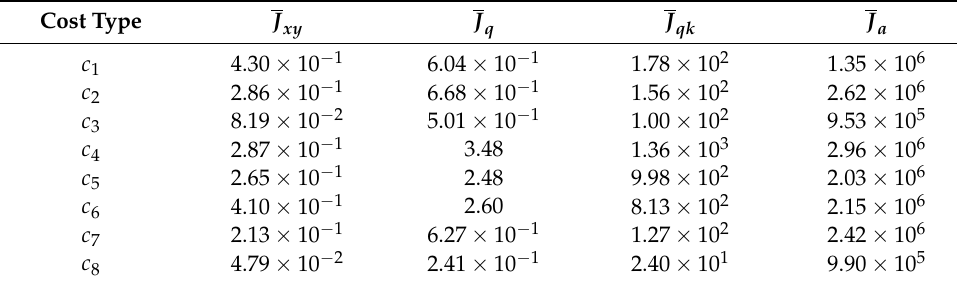
Table 6. Comparison of quality indicators depending on the various cost for control type U